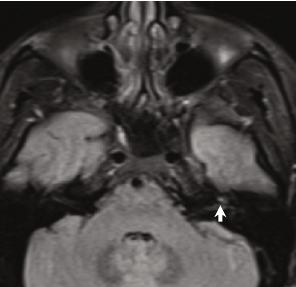
Figure 2: Magnetic resonance imaging: axial T2 FLAIR image showing hyperintensity of the left